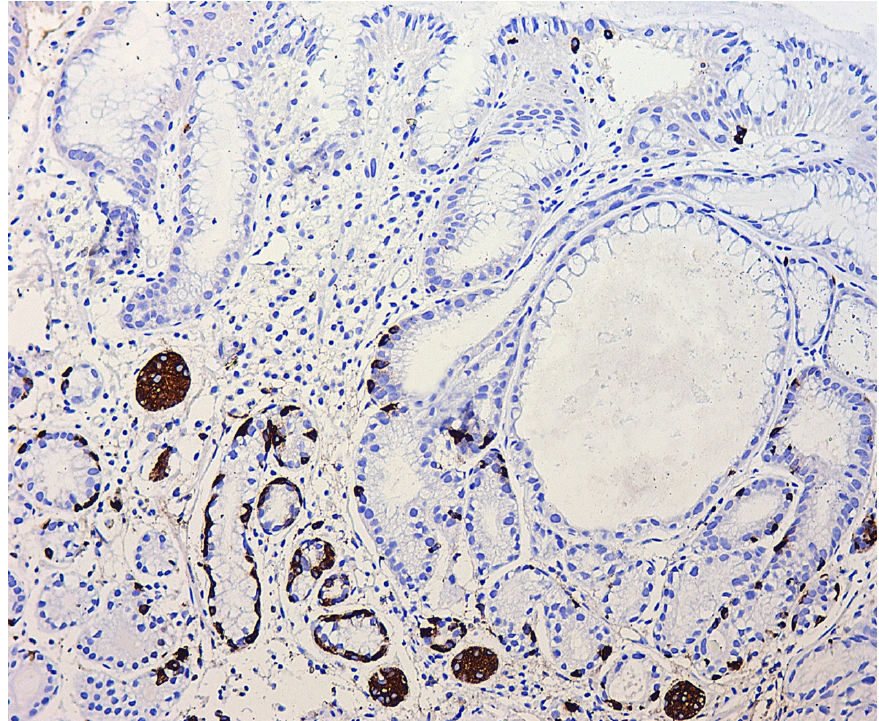
Figure 4. Autoimmune gastritis. Biopsy from the gastric body. Marked pseudopyloric metaplasia. Signs of linear and micronodular hyperplasia of neuroendocrine cells. Immunohistochemical reaction with antibodies to chromogranin A. ×200 (from the personal archive of Professor S.I. Mozgovoi).